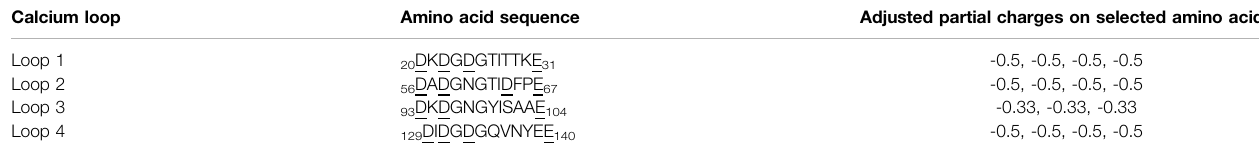
TABLE 3 | The adjusted partial charges of the negatively charged residues participated in calcium coordination in the four calcium-binding loops of CaM. The amino acid sequences of the calcium-binding loops are provided as a reference. The subscript indices stand for the positions of the starting/ending residues in the CaM sequence. Underscored residues are the selected amino acids with negative charges as shown in the third column. We adjusted the partial charges on the sidechain beads of those residues based on the bipyramidal pentagonal coordination geometry of the calcium ion. Calcium